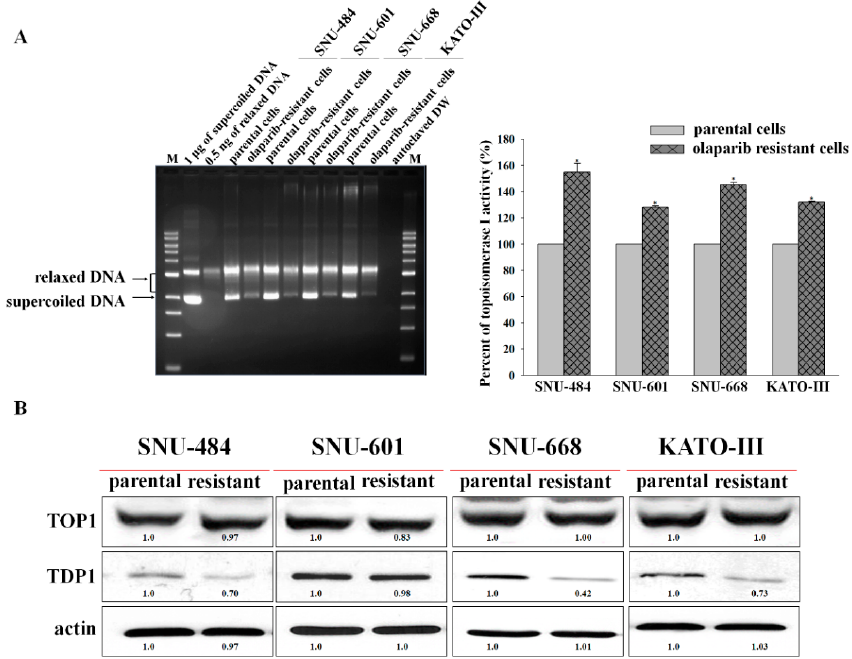
Figure 4. Topoisomerase 1 (TOP1) activity was increased and tyrosyl-DNA phosphodiesterase 1 (TDP1) expression was downregulated in olaparib-resistant cells. TOP1 activity was increased in all olaparib-resistant cells compared with parental cells ( A ), although the protein expression of TOP1 was not altered ( B ). TDP1 protein expression was downregulated in olaparib-resistant SNU-484, SNU-668, and KATO-III cells compared with their parental cells ( B ). * indicates p <